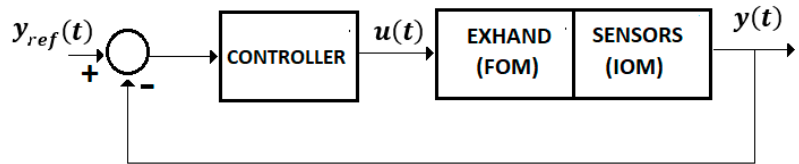
Figure 4. Control Figure 4. Control system.